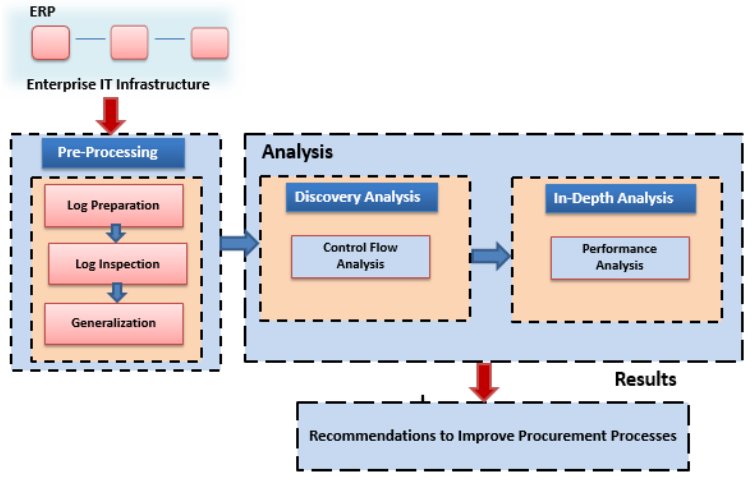
Figure 2. The process mining methodology